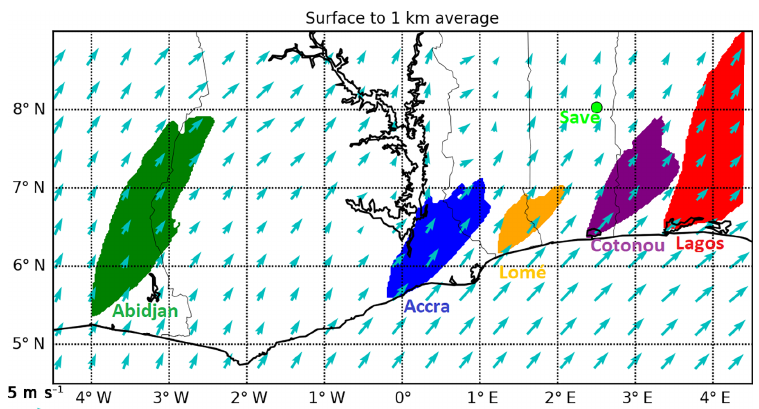
Figure 7. Maps of URB tracer concentration (in arbitrary units) averaged over the period of 1 to 7 July 2016 in the monsoon layer (from the surface to 1kma.m.s.l.). Tracers are released from Abidjan (Côte d’Ivoire) in green, from Accra (Ghana) in blue, from Lomé (Togo) in orange, from Cotonou (Benin) in violet, and from Lagos (Nigeria) in red. The same threshold of tracer concentration is used for all city plumes for the color shading (Iso1). Wind vectors at 10m modeled by WRF are presented by the light blue arrows. The location of the DACCIWA super-site (Savè in Benin) is presented by the light green dot.